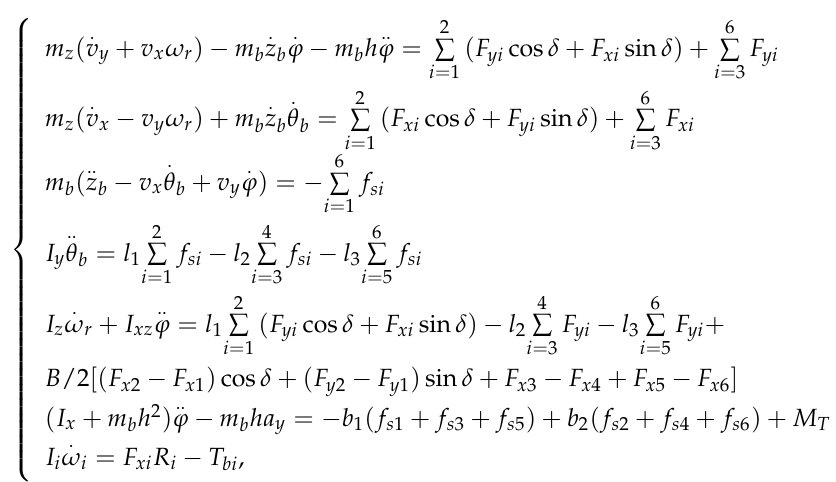
The suspension force can be expressed as Equation (2).